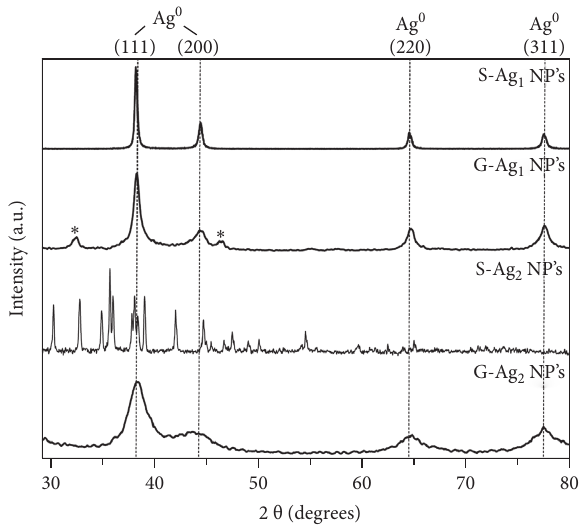
Figure 4: X-ray diffraction (XRD) patterns of “green” and non- green silver NPs before and after the sulphuration